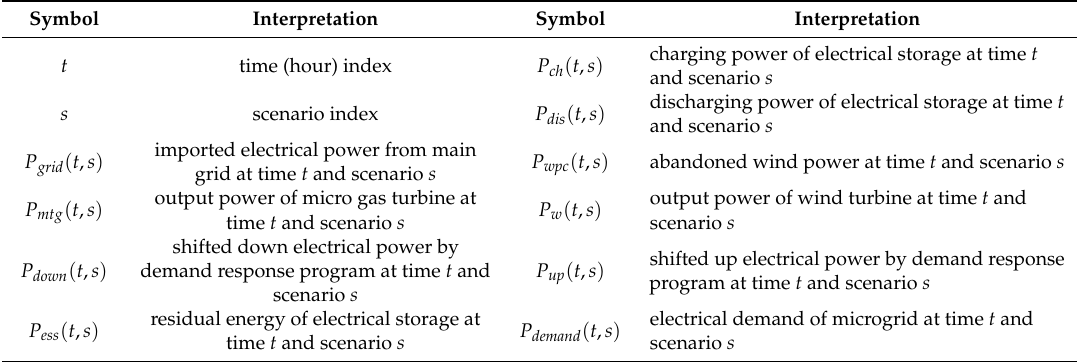
Table 1. The interpretations of symbols of